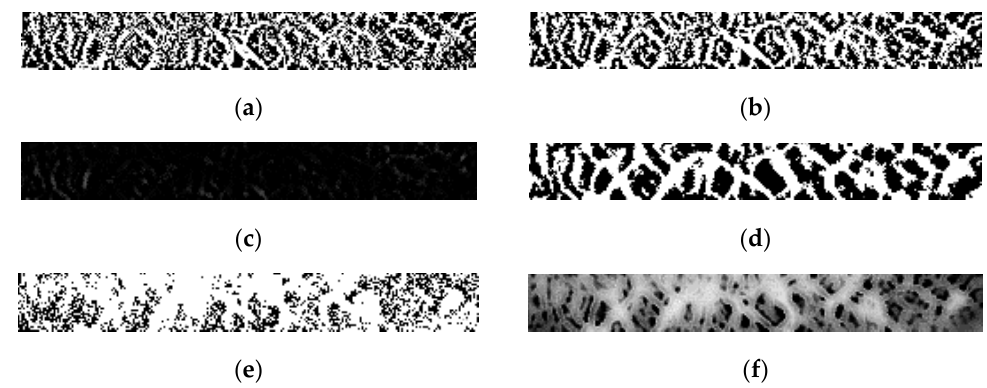
Figure 7. Original image and six different filtered processed images: ( a ) I ris original image; ( b ) Gaussian filter; ( c ) Square filter; ( d ) Median filter; ( e ) Bilateral filter; ( f ) Equalization histogram; ( g ) Laplacian of Gaussian.